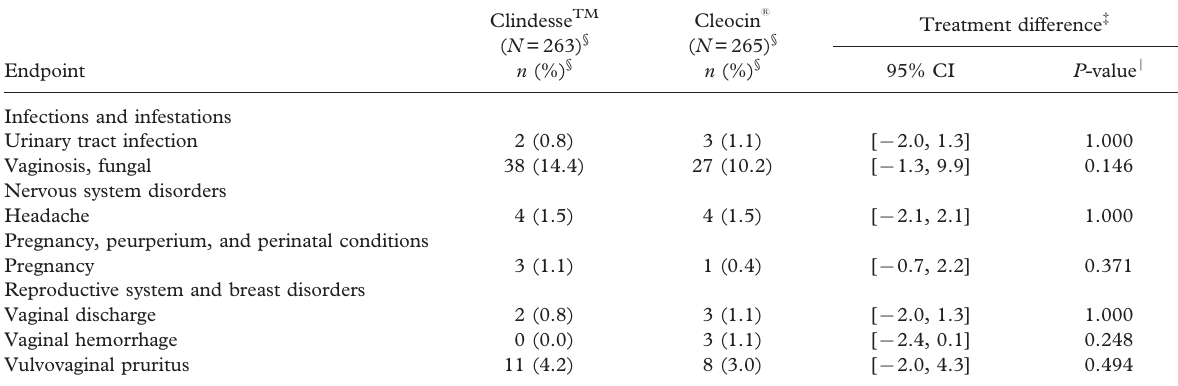
Table IV. Most commonly reported adverse events (intent-to-treat population) {